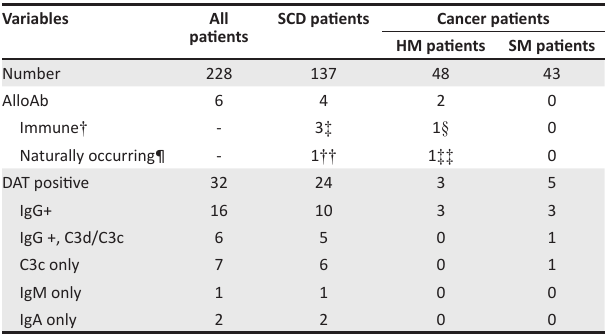
TABLE 2: Serological results of transfused sickle cell disease and cancer patients at Kenyatta National Hospital, Nairobi, Kenya, 2014. Variables All patients